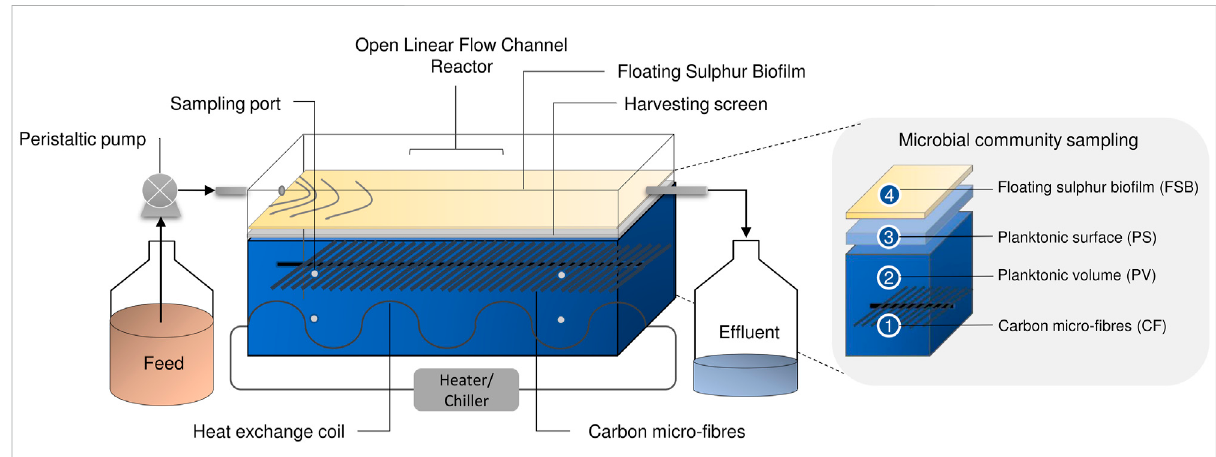
FIGURE 1 Schematicdiagram showing thehybrid LFCRcon fi guration and microbial ecology sampling of theCF, PV, PS,and FSB communitiestaken after operation at 30 and 10 ° C for 16S rRNA sequencing [adapted from Marais et al. (2020b)].